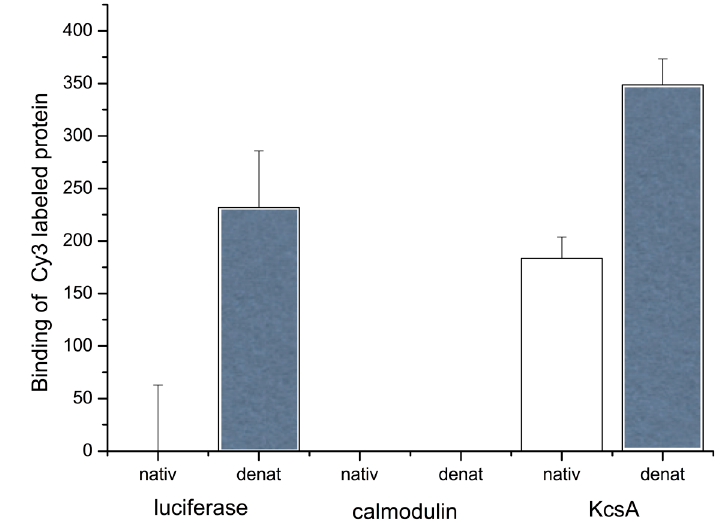
Figure 3. Binding of labeled potential client proteins to HSP90 α. Signal intensities were analysed at the wavelength 532 nm with a gain of